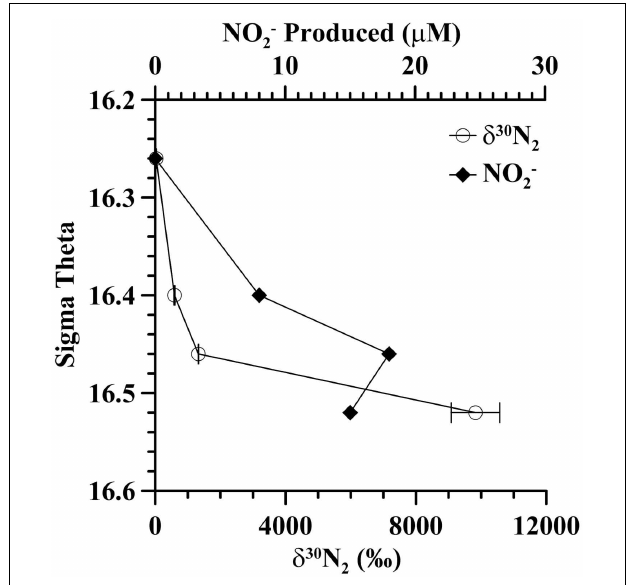
FIGURE 4 |Autotrophic denitrification activity at the mixing zone station in 2005 as indicated by 30 N 2 production (circles) during incubations with 15 N-labeled nitrate. Nitrite was also formed during the incubation (diamonds). Error bars indicate duplicate measurements.